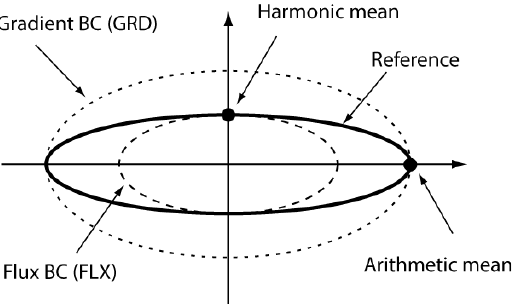
Figure 21. Schematic representation of the 3 permeability tensors ellipsoids for a finite 3 horizontal layers block (matrix/fracture block).